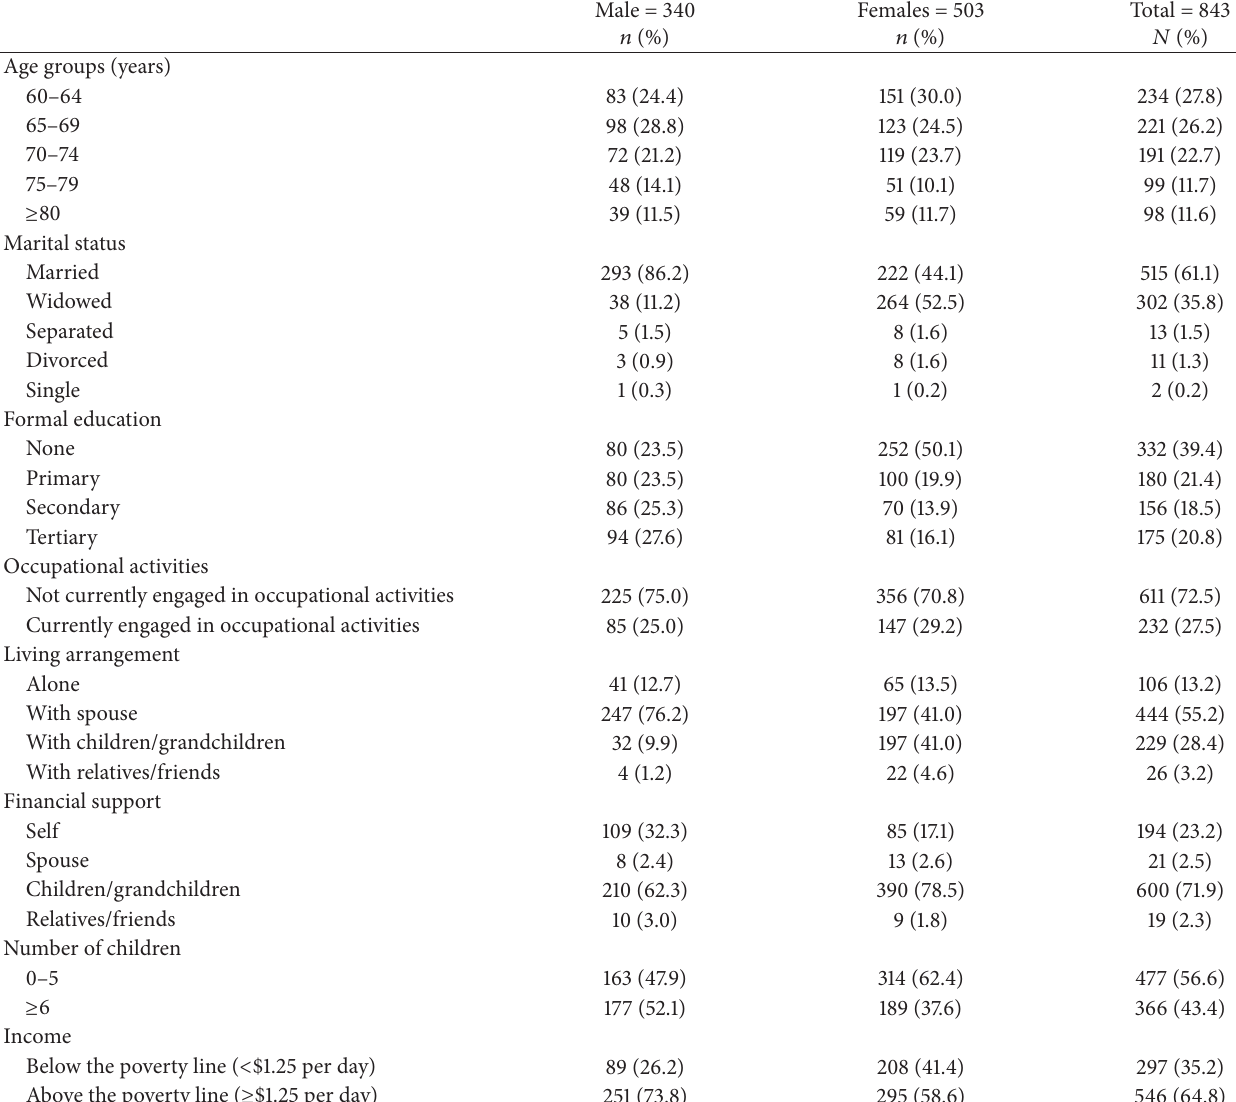
Table 1: Sociodemographic